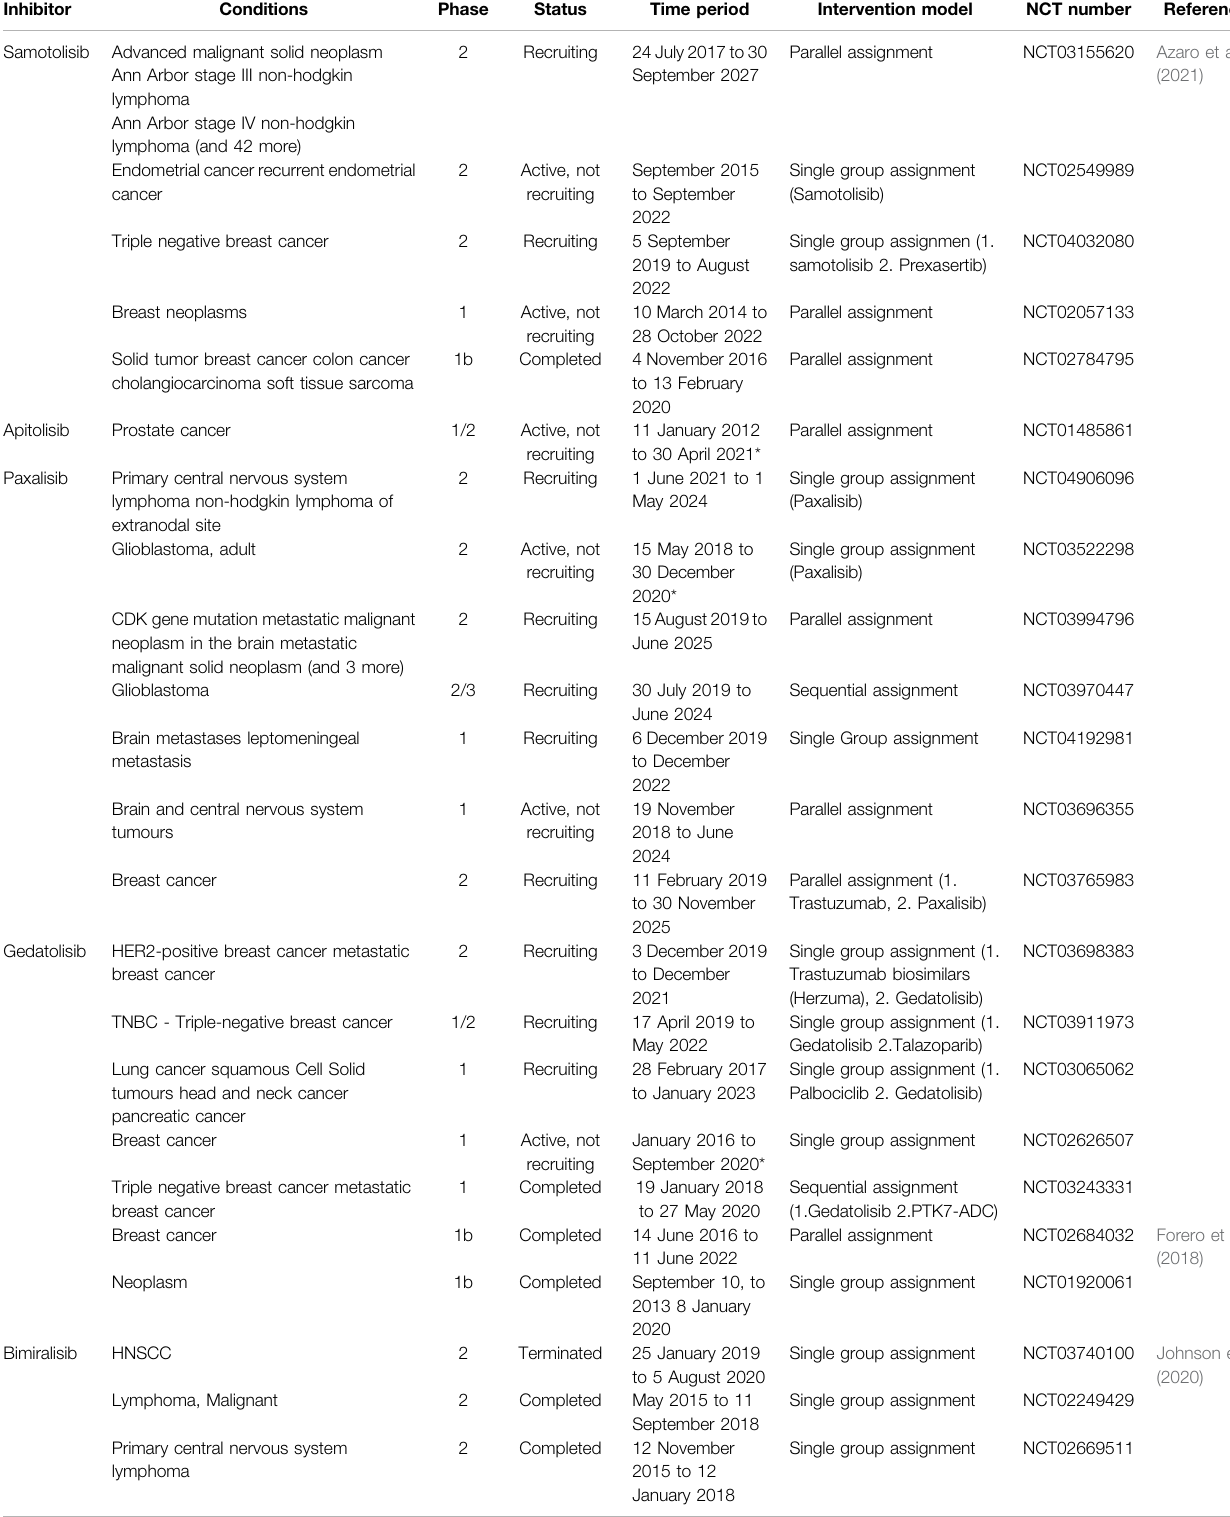
TABLE 1 | Dual PI3K/mTOR inhibitors in current clinical trials that listed in the